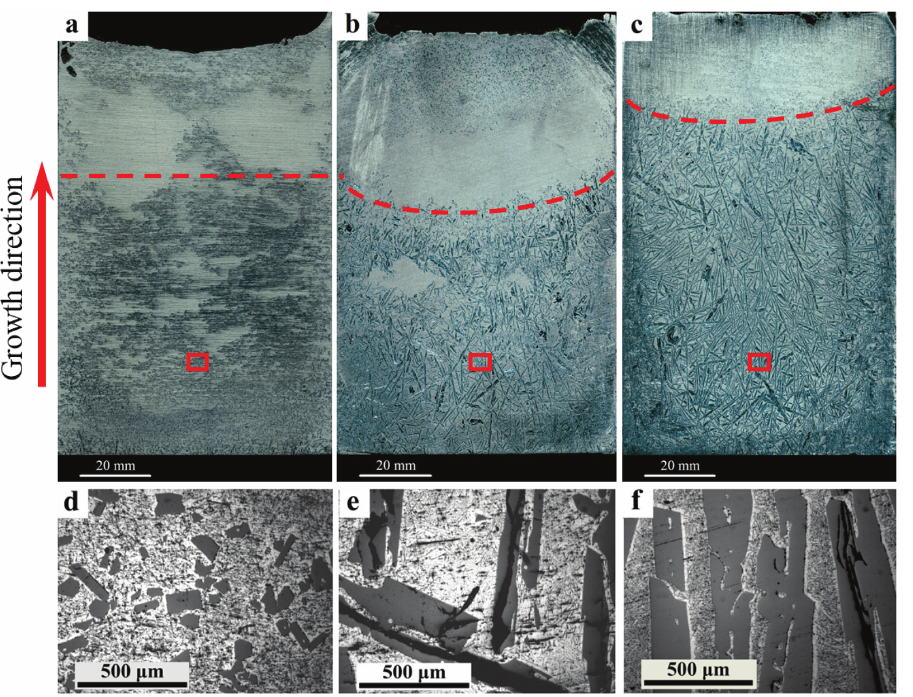
Figure 4: Photographs of vertical cross section of solidified Al-Si ingots. (a) Al-20Si; (b) Al-30Si; (c) Al-40Si; and their corresponding optical microstructures (d), (e) and (f) of the marked